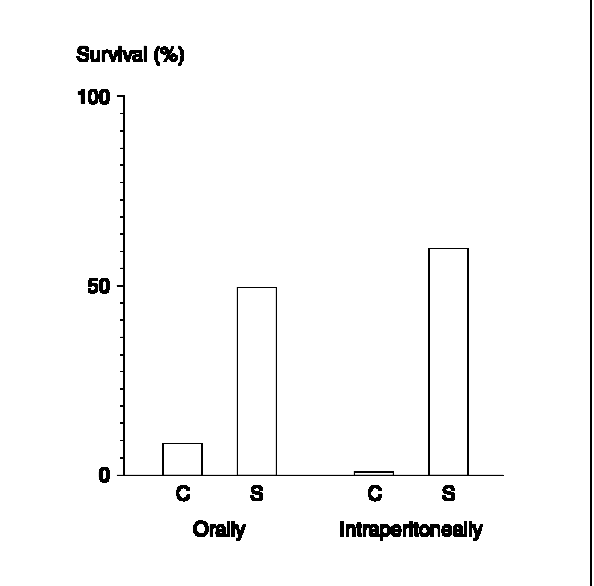
FIG. 3. Protective effect of an oral administration (50 mg/kg body weight per day) of schizophyllan against infection by the rod- shaped DNA virus of Penaeus japonicus (RV-PJ) in Kuruma shrimps.